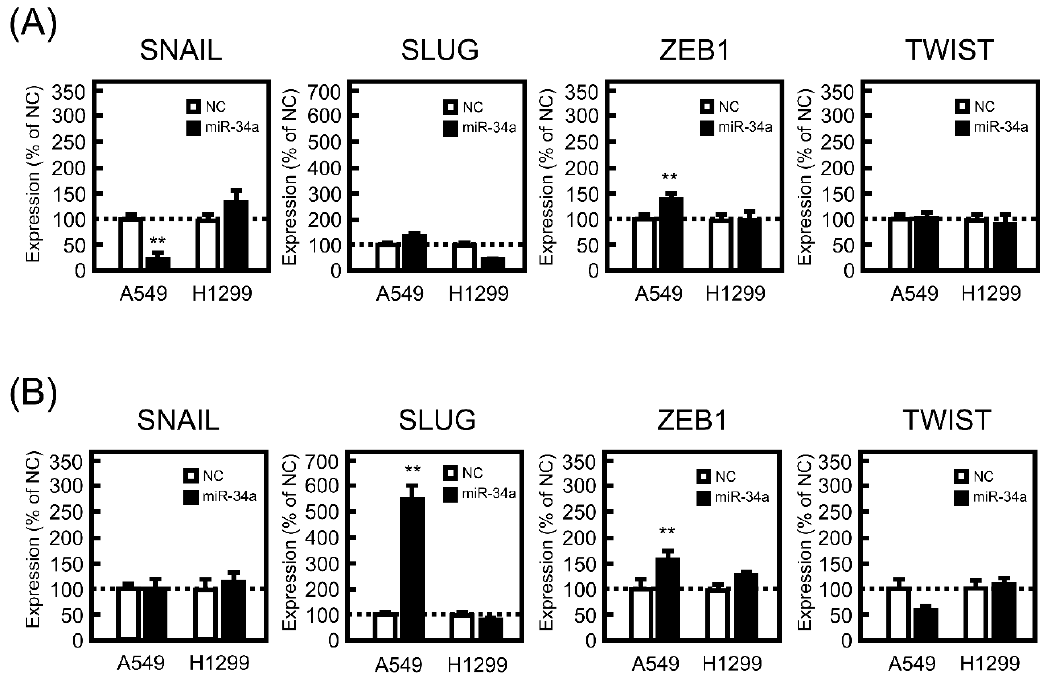
Figure 3. Effect of miR-34a overexpression on EMT-related transcriptional factors in A549 and H1299 cells. These cells were transfected with NC (20 pmol/well) or miR-34a mimic (20 pmol/well) for 24 h. After 24 ( A ) or 72 h ( B ), the mRNA expression levels of SNAIL, SLUG, zinc finger E-box binding protein (ZEB)-1, and TWIST were measured by real-time PCR. Each value represents the mean ± S.E.M. (n = 3). ** p < 0.01, significantly different from NC.